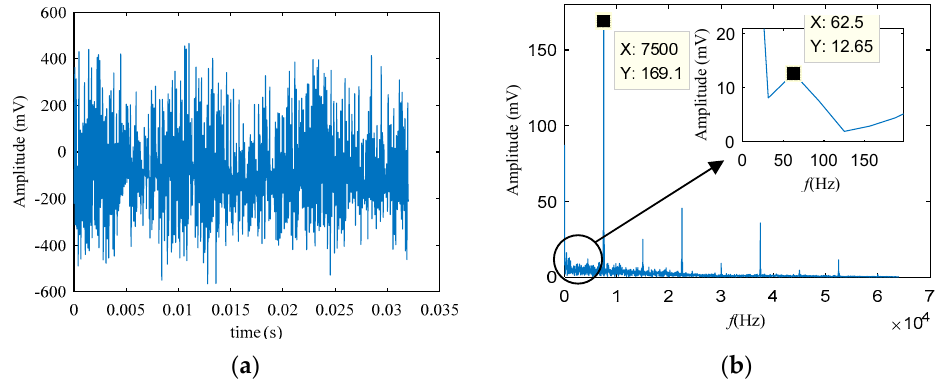
Figure 8. The original signal with 93 Hz. ( a ) the waveform of the original signal. ( b ) the frequency spectrum.